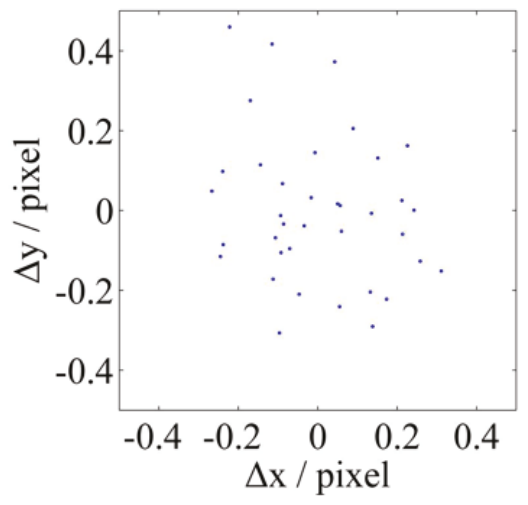
Figure 6: Residuals of the fish-eye sun sensor calibration.